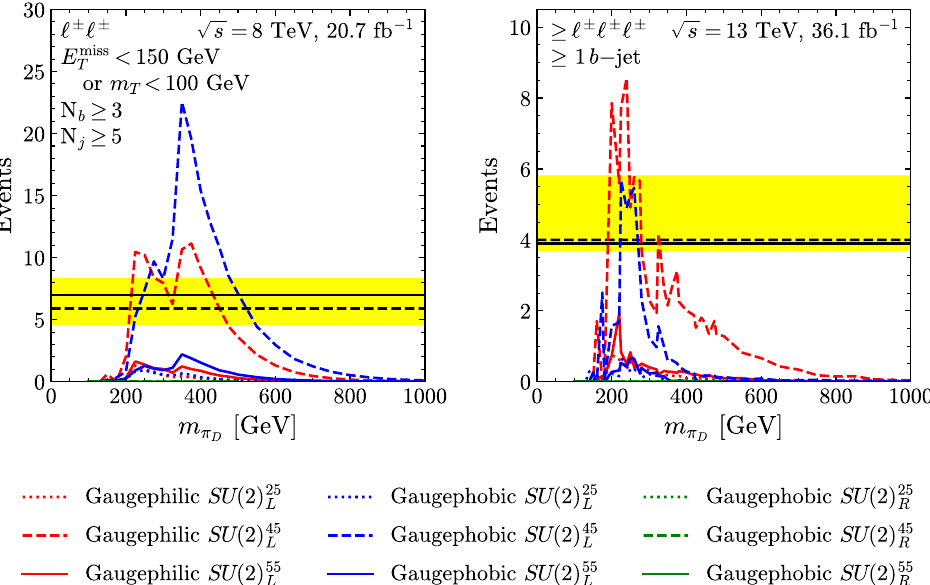
Figure 12 . Signal regions of ATLAS searches for three leptons or same sign leptons which have sensitivity to our benchmarks. The left panel shows the limits from the 8 TeV analysis [151] and the right panel has the limits for the 13 TeV analysis [152]. The 8 TeV analysis has bounds to the largest values of m for all of the 8 and 13 TeV analysis which we studied. The 13 TeV search π D does not do as well because the focus of the analysis shifted to search for higher mass